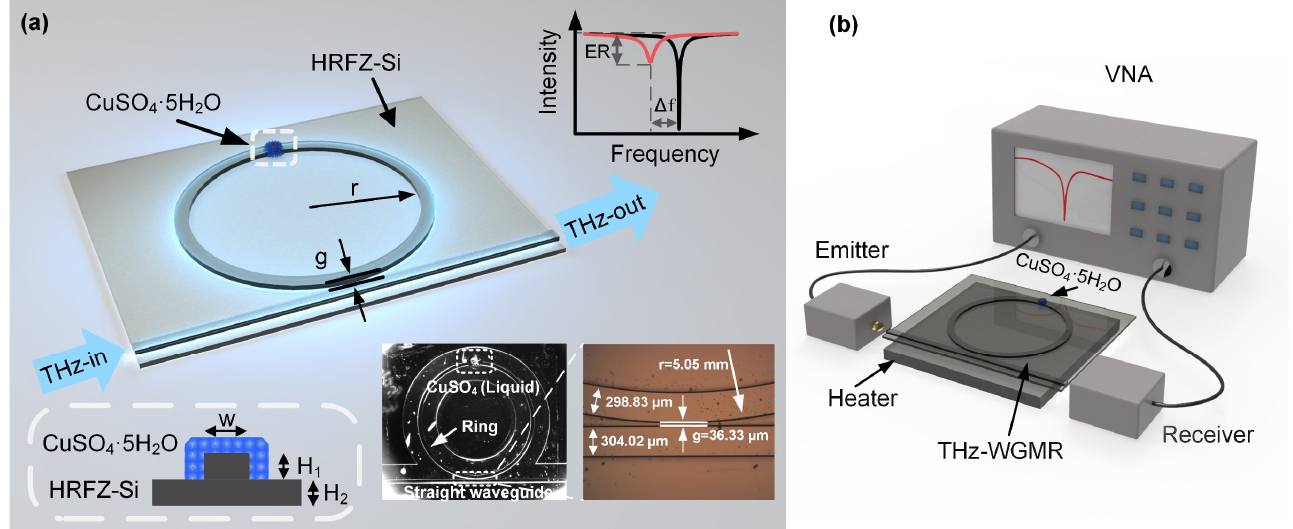
Figure 1. The schematic diagram of the terahertz whispering gallery mode resonator (THz-WGMR) together with its sensing principle and the diagram of the experimental setup. ( a ) The schematic diagram of the THz-WGMR. The inset in the lower left shows the cross-section of the ridge waveguide. The spectra in the upper right illustrate the principle of sense. The photographs in the lower right show the real chip which consists of a straight coupling waveguide and a ring resonator. The supersaturated CuSO 4 solution of 0.5 μ L covers the ring resonator. The optical microscopic image on the right shows the coupling region of the THz-WGMR. ( b ) The illustration of the experimental setup. The heating plate under the chip is used to adjust and maintain the temperature. The end faces of the straight waveguide are aligned with the emitter and receiver, and the transmission spectrum is shown on the screen of the vector network analyzer (VNA).